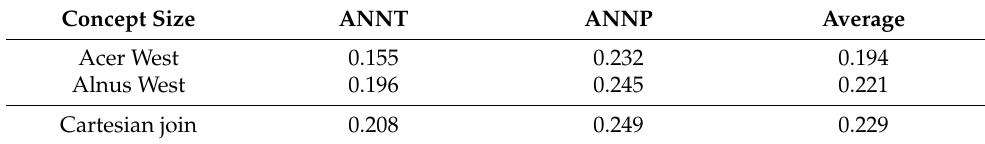
Table 2. The average concept sizes for two hardwoods and their Cartesian join.